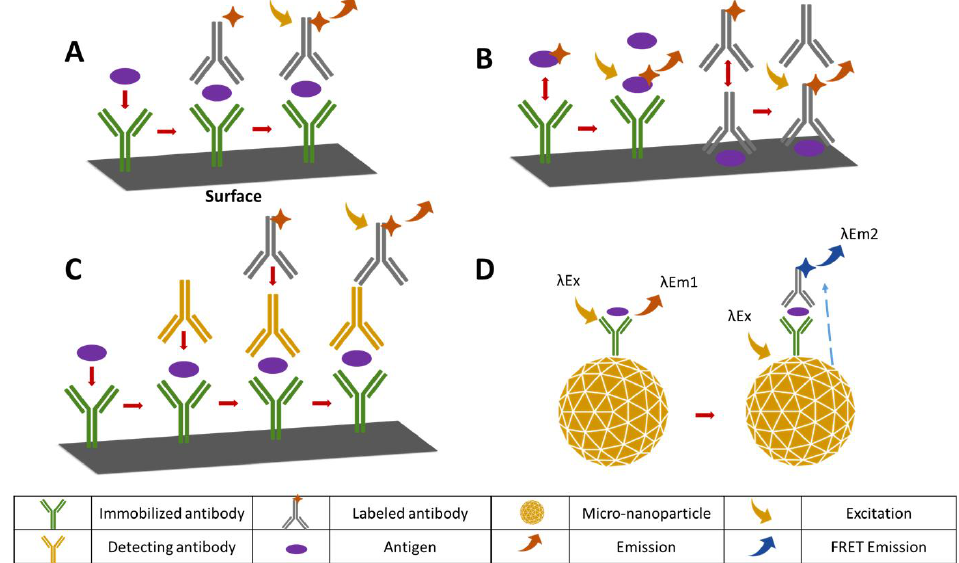
Figure 3. Possible immunoassay binding configurations: ( A ) sandwich structure formation ( B ) competitive style immunoassays ( C ) extended sandwich structure formation ( D ) sandwich structure formation on a (micro-nanoparticle) surface.